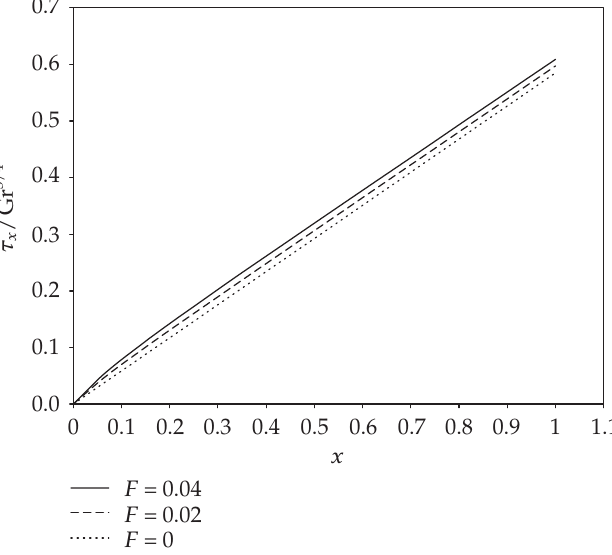
Figure 5.11 . The e ff ect of radiation parameter on local skin friction at M = 1, m = 1, and Pr = 0 .